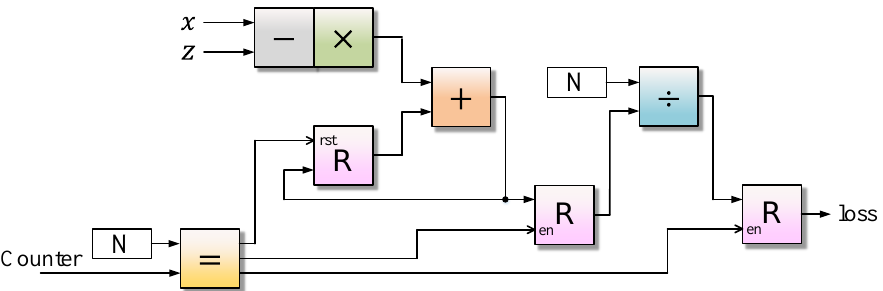
Figure 6. Loss Function: Core processor calculates the Mean Squared Error